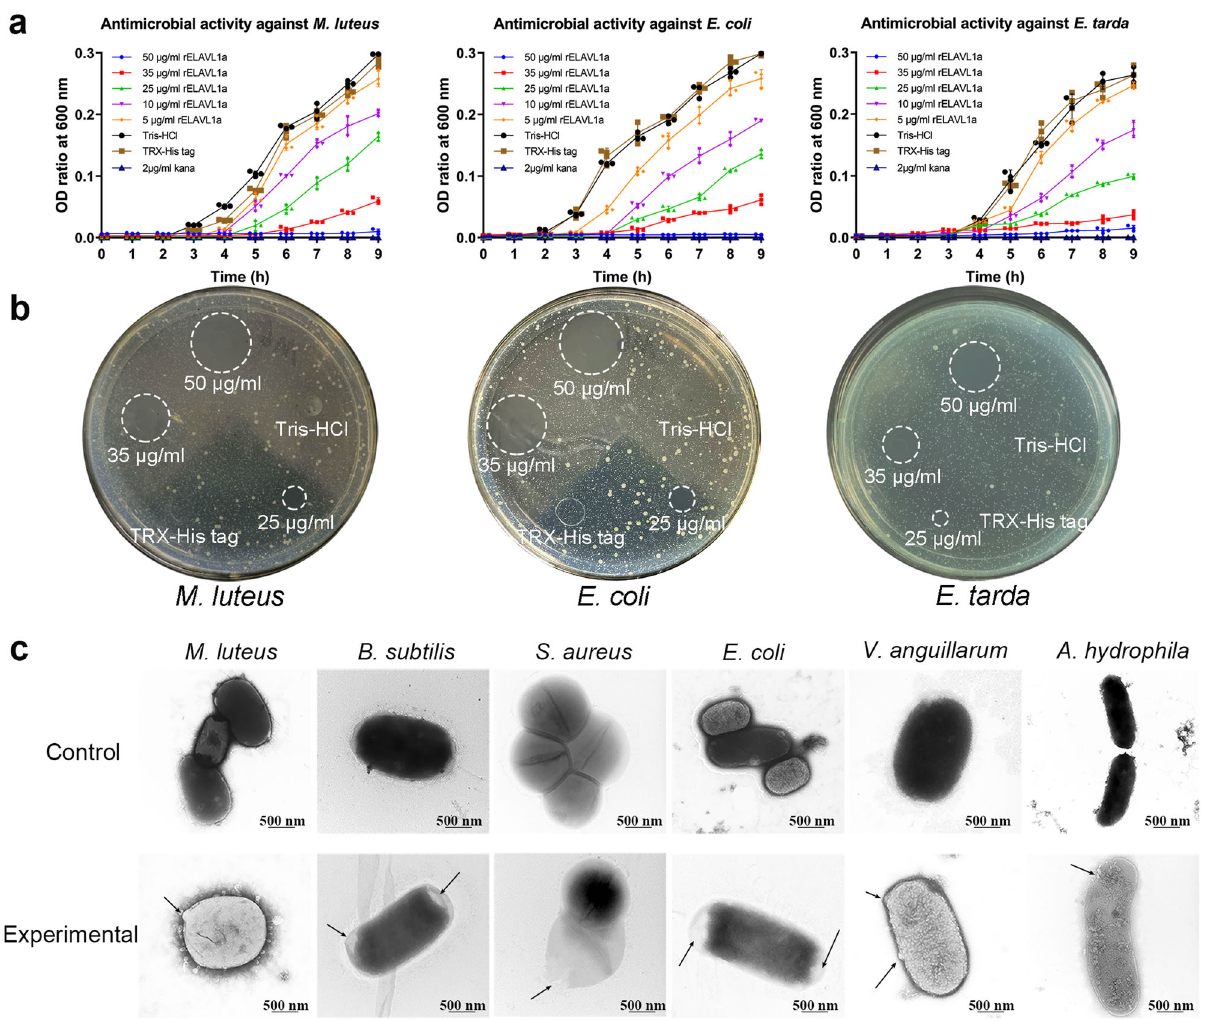
Fig. 4 Antibacterial activity of rELAVL1a and its effects on bacterial structures. a Antibacterial activities of rELAVL1a against Gram-positive bacteria M. luteus and Gram-negative bacteria E. coli and E. tarda . Each point in the graph represents the mean ± S.D. ( n = 3). The data are from three independent experiments performed in triplicate. The bars represent the mean ± SD. b The halos showing antibacterial activities of rELAVL1a against representative bacteria, including the Gram-positive bacterium M. luteus and the Gram-negative bacteria E. coli and E. tarda . The halos without the cup (bottom) were shown. c Transmission electron microscopy. Control, M. luteus , B. subtilis , S. aureus , E. coli , V. anguillarum and A. hydrophila incubated with PBS;